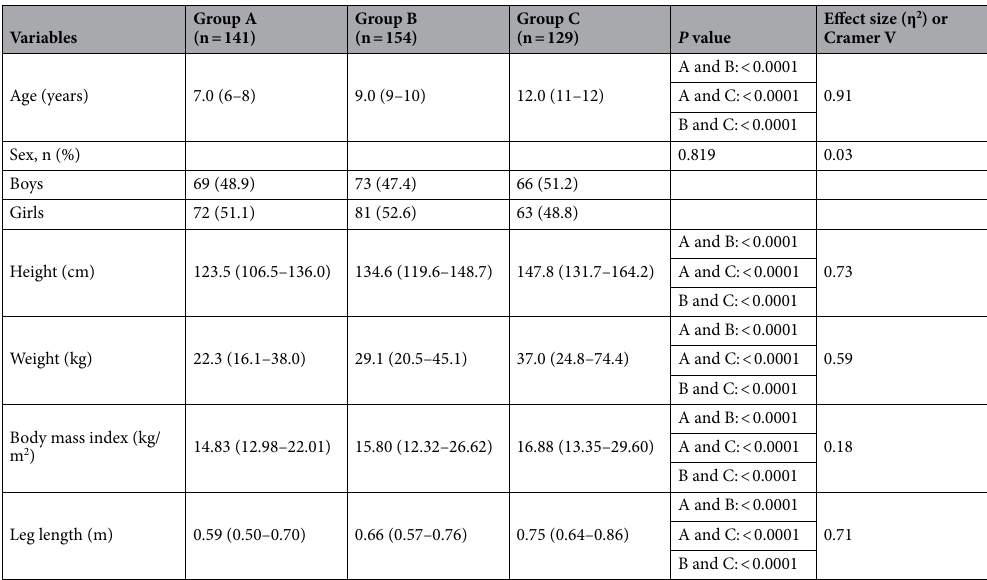
Table 1. Demographic characteristics of the participants (N = 424). Group A (6–8 years), Group B (9–10 years), Group C (11–12 years). Differences in age, height, weight, body mass index, and leg length, but not sex, between the three groups were analyzed using the Kruskal–Wallis test. Variables with significant differences were subsequently compared using multiple comparison analyses with Bonferroni correction. Data are presented as median values (ranges). The P value for sex was derived using the Chi-square test. P values < 0.0001 were considered statistically